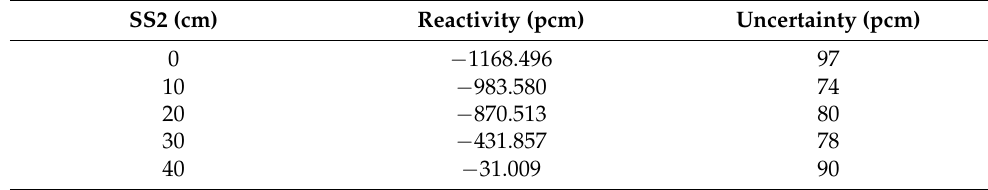
Table 2. Reactivity values during the start-up of PUR-1 by withdrawing the SS2 control rod.